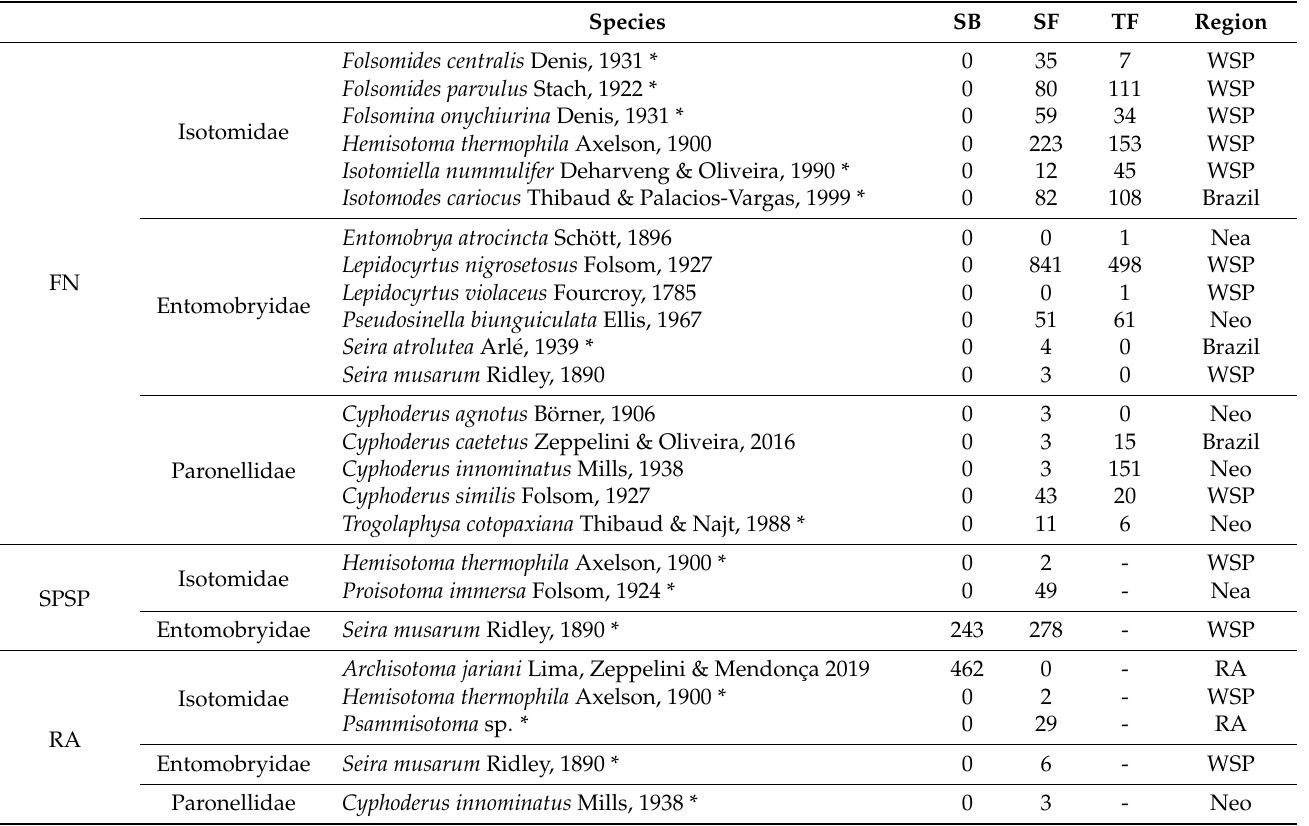
Table 1. Entomobryidae species recorded in Fernando de Noronha, S ã o Pedro e S ã o Paulo and Rocas Atoll. Abundance in environmental areas (SB, SF and TF), and biogeographic region of occurrence of the species. Neo, neotropical species, WSP, occurs in at least 3 biogeographic regions. *, new records; -, non-existent